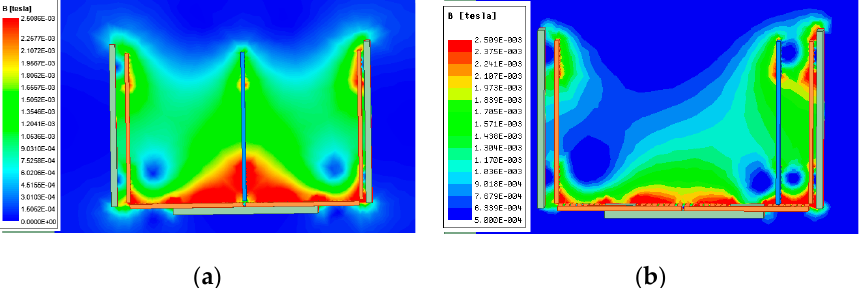
Figure 12. ( a ) Magnetic field distribution during alignment of concave structures. ( b ) Magnetic field distribution during the offset of the concave structure.